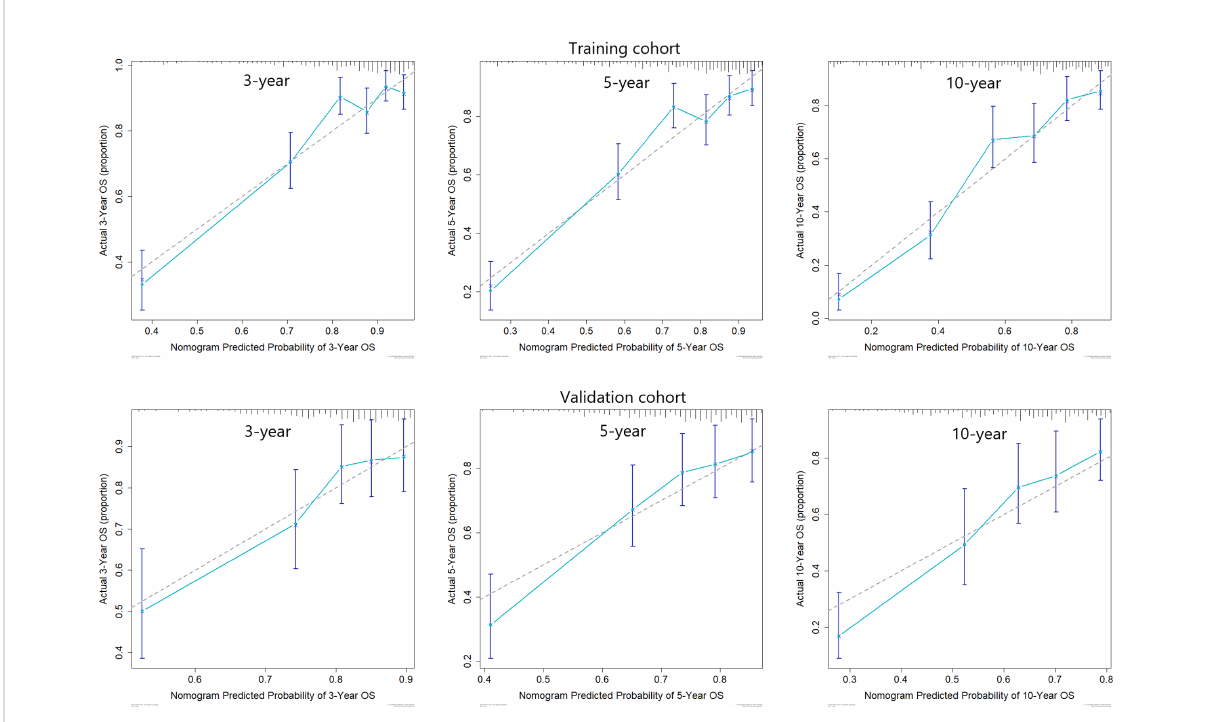
FIGURE 2 Calibration curves for 3-, 5-, and 10-year OS among patients with FIGO stage I/II ECCC within the training and validation cohorts.